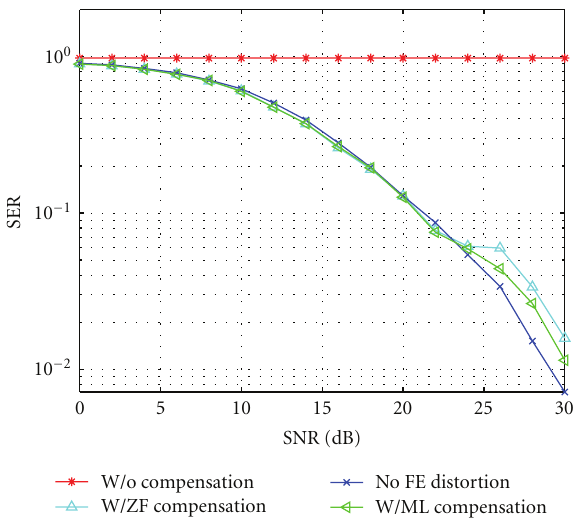
Figure 15: Measured SER versus SNR performance curves for 64- QAM OFDM system with preamble pilot; CFO = 10KHz; veh. A channel model with 39 taps; ensemble average over 10 realizations with a fixed